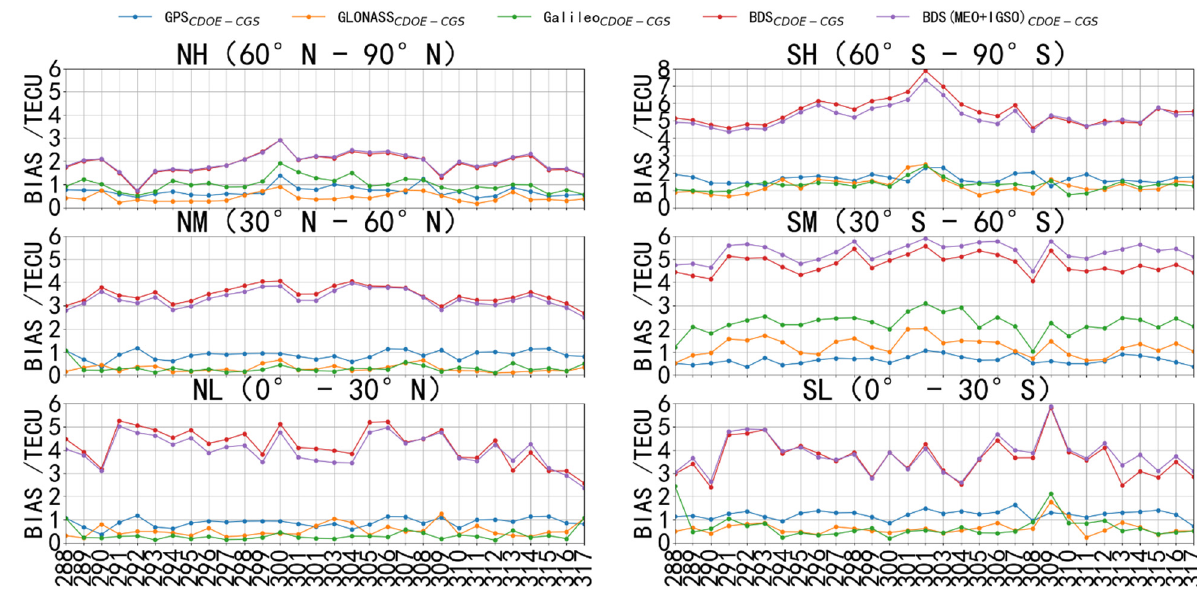
Figure 8. Biases between GIMs and CODE GIMs of four systems during active ionospheric days.